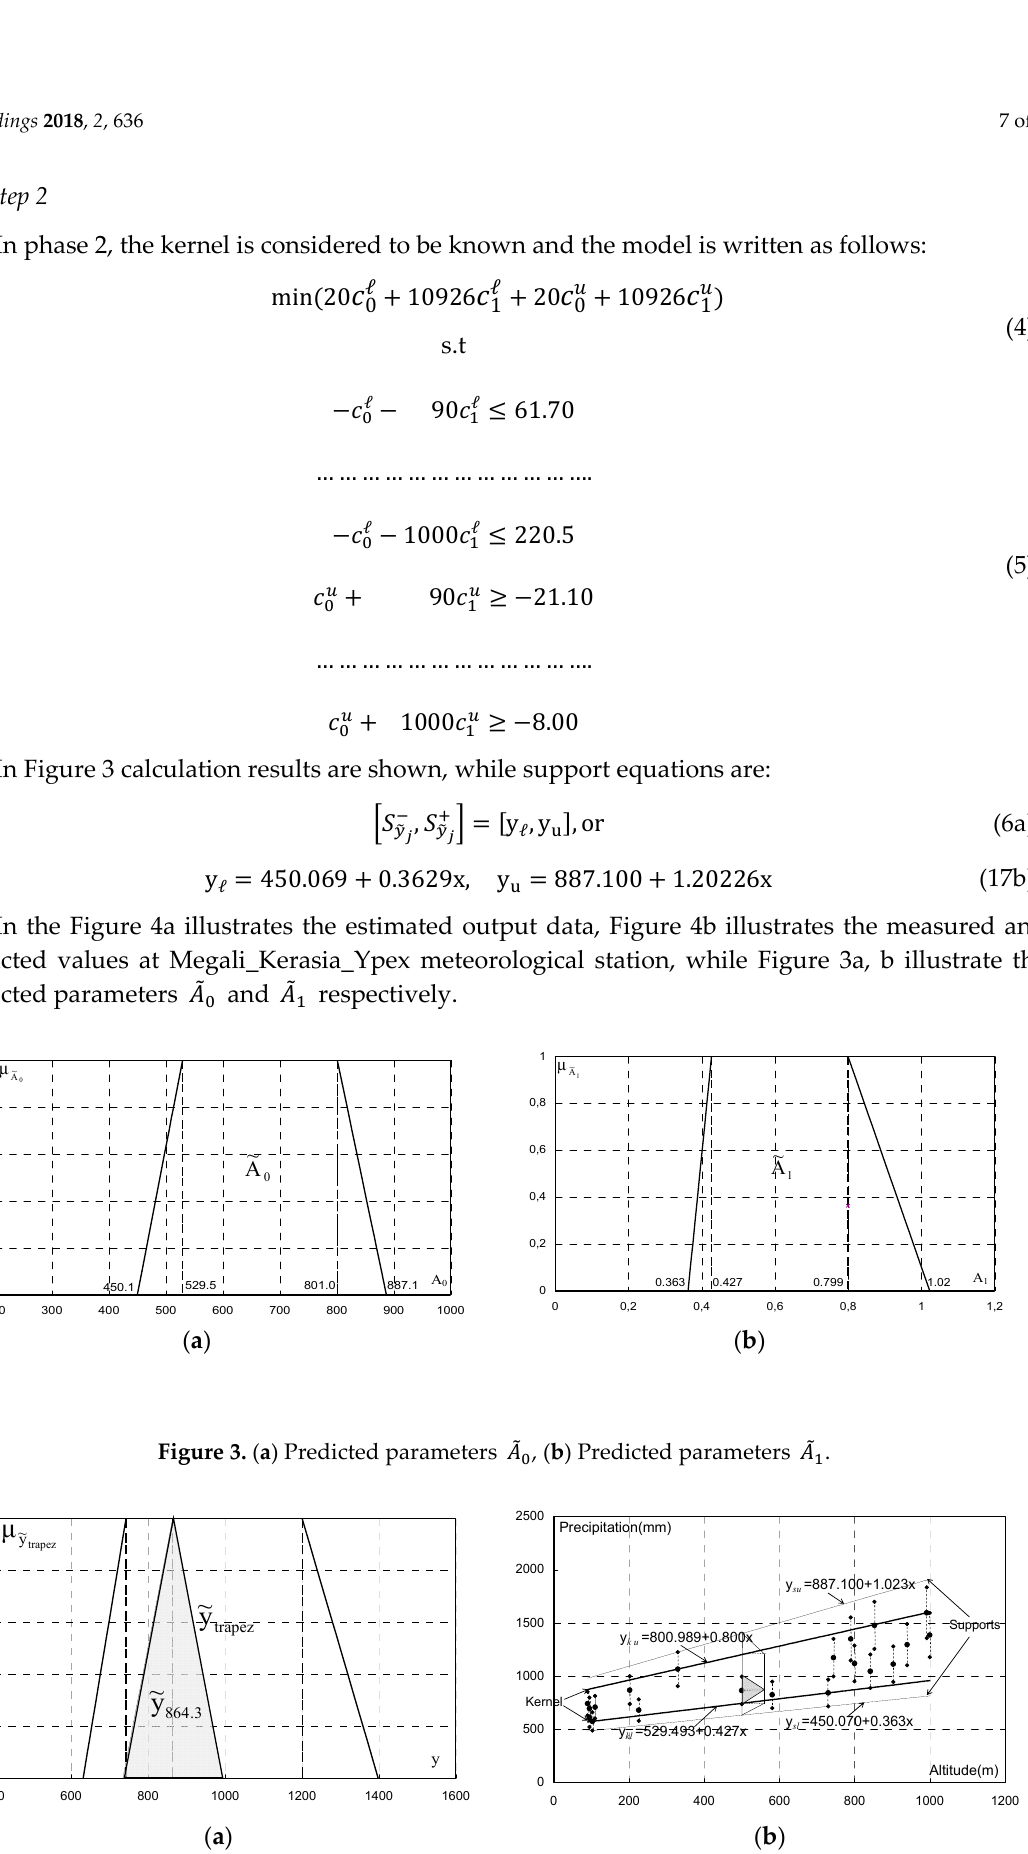
Figure 4. ( a ) Estimated fuzzy output data, ( b ) Measured and predicted output at Meg._Ker._Ypex